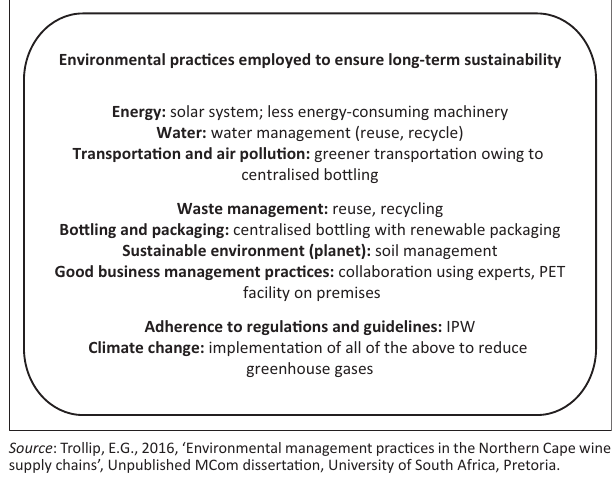
FIGURE 1: Summary of environmental practices applied by the